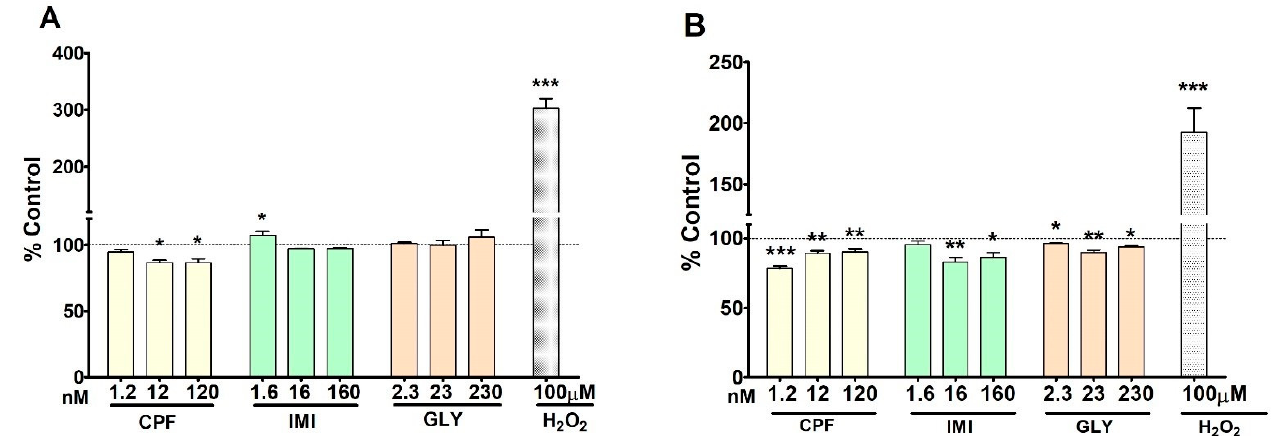
Figure 5. Intracellular ROS production in MCF-7 cells ( A ) and MCF-12A cells ( B ) treated with CPF, IMI, GLY or H 2 O 2 as a positive control. Values are means ± SEM of three independent experiments with control cells set at 100%. Asterisks indicate statistically significant differences with respect to control cells: * p < 0.05; ** p < 0.01; *** p < 0.001.